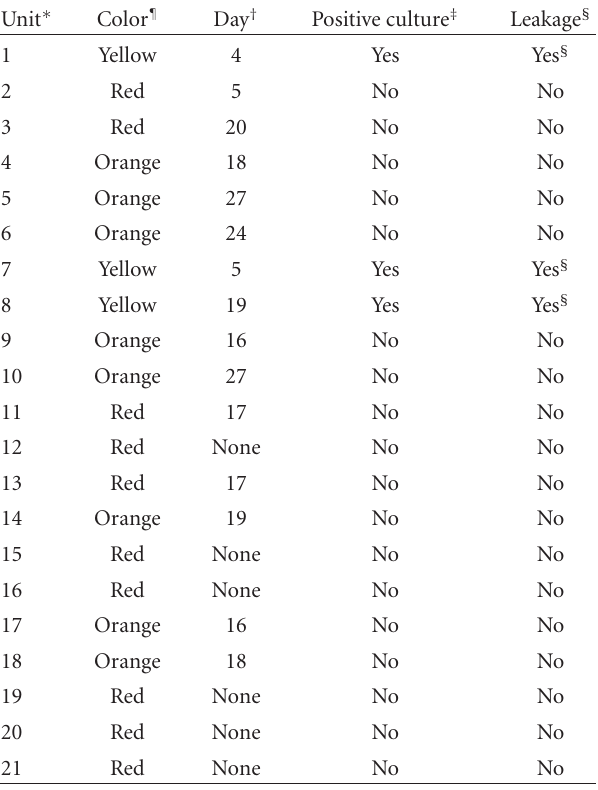
Table 2: Color change and culture findings in lower chamber of NSP